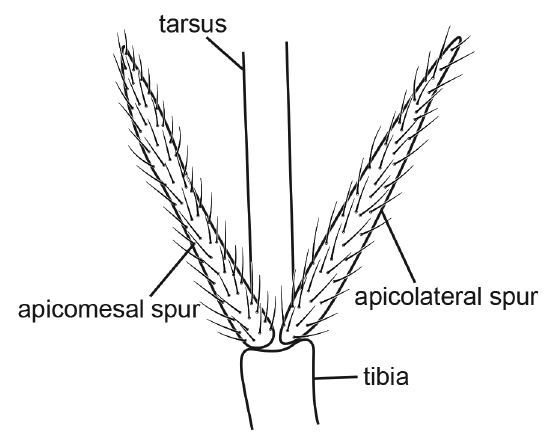
Figure 6. Male of Metalype fragilis (Pictet, 1834). Apical spurs of right hind leg,